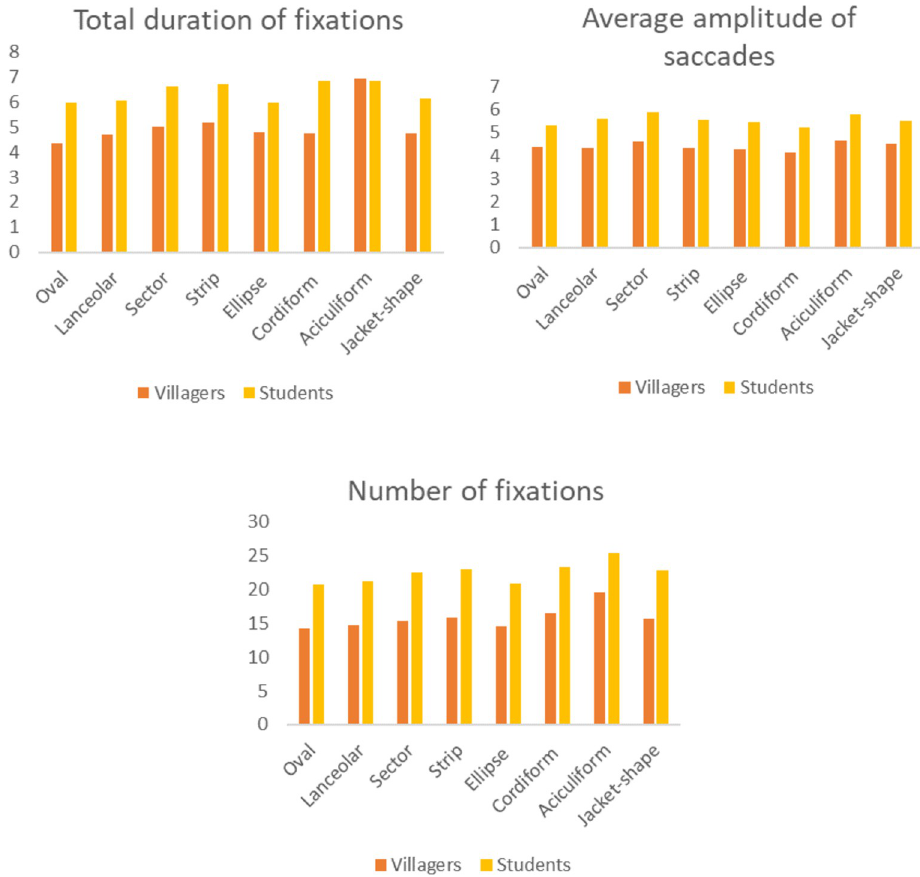
Fig 4. The average value of eye movement indicators of villagers and students with different leaf shapes.